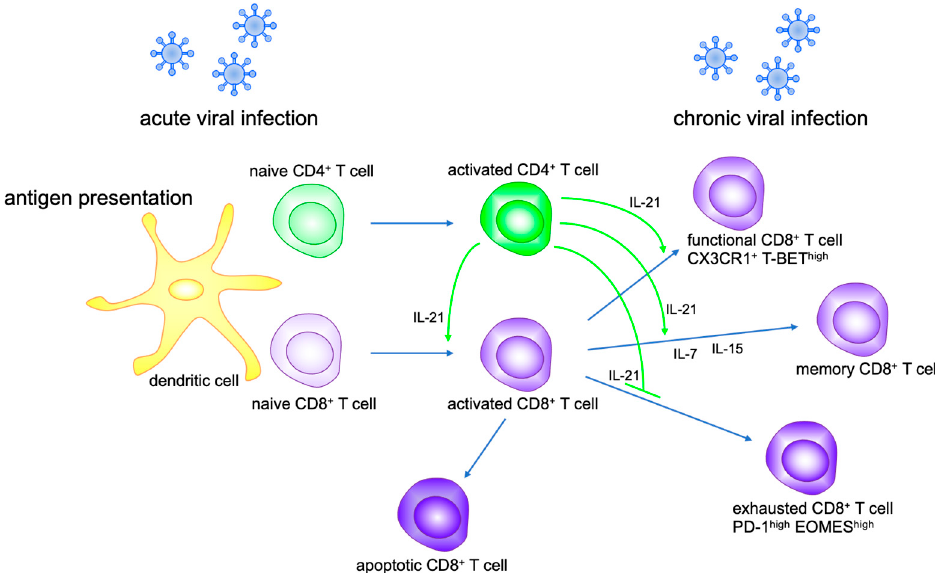
Figure 2. IL-21 modulates CD8 + T cell function. IL-21 secreted by activated CD4 + T cells promotes CD8 + T cell activation and proliferation, and differentiation to memory CD8 + T cells with IL-7 and IL-15. IL-21 maintains functional CD8 + T cells and prevents CD8 + T exhaustion in chronic viral infection.